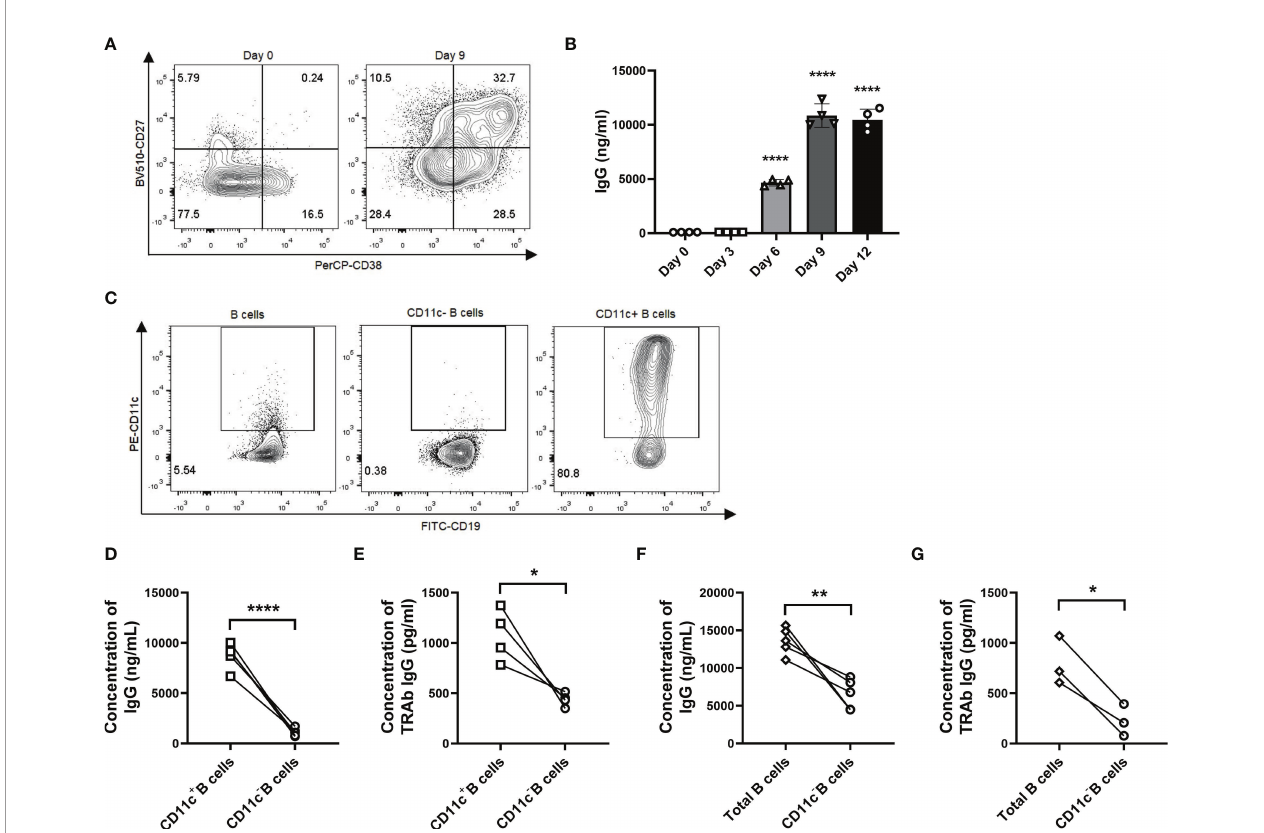
FIGURE 7 | CD11c + B cells are activated to differentiate into autoreactive ASCs that secrete IgG and TRAbs. (A) Representative fl ow cytometric plots of plasmablasts (CD27 high CD38 high B cells, top right panel) in CD19 + B cells from GD patients before culture (left, day 0) and after 9 days of culture (right, day 9). (B) The measurement of IgG in culture supernatants was carried out continuously for up to 12 days. Data were assessed by ANOVA, and the groups were compared between day 0 and days 3, 6, 9, and 12, with the results marked above the histogram bars. (C) Representative fl ow cytometric plots of total CD19 + B cells, CD11c - B cells, and CD11c + B cells from GD patients. (D) Comparison of the IgG concentration in culture supernatants between paired CD11c + B cells and CD11c - B cells in each batch from different GD patients. (E) Comparison of the TRAb concentration in culture supernatants between paired CD11c + B cells and CD11c - B cells in each batch from different GD patients. (F) Comparison of the IgG concentration in culture supernatants between paired total B cells and CD11c - B cells in each batch from different GD patients. (G) Comparison of the TRAb concentration in culture supernatants between paired total B cells and CD11c - B cells in each batch from different GD patients. Data are represented as the mean ± SD and were compared between two groups with a paired Student ’ s t test. P < 0.05 was considered statistically signi fi cant. ns, not signi fi cant; * P < 0.05; ** P < 0.01; **** P <